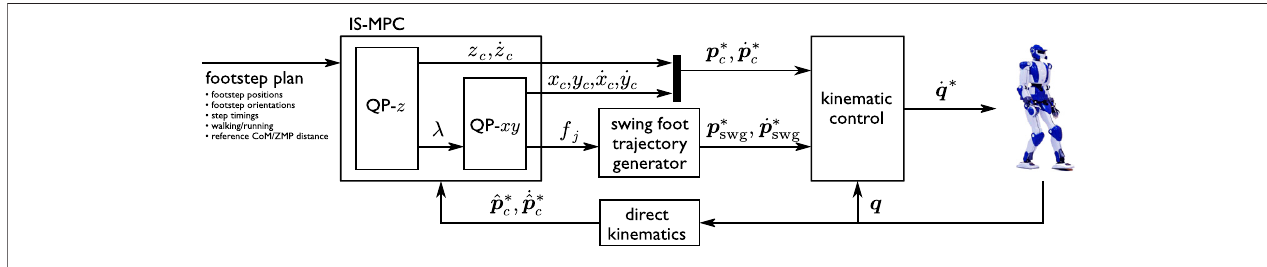
FIGURE 3 | A block scheme of the proposed